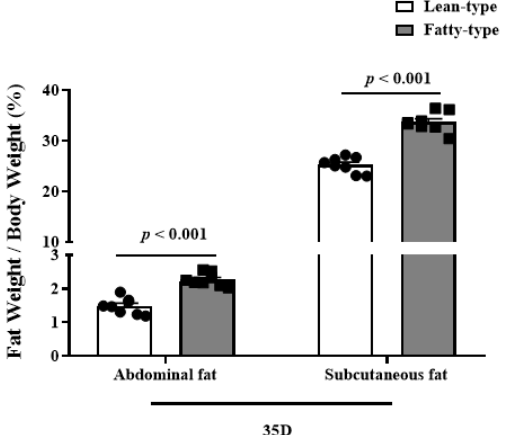
Figure 3. Comparison of abdominal fat and subcutaneous fat contents at 35 D between two strains of meat duck. Data are given as means and standard error of the mean ( n = 8). p -values are shown after comparison of two strains.